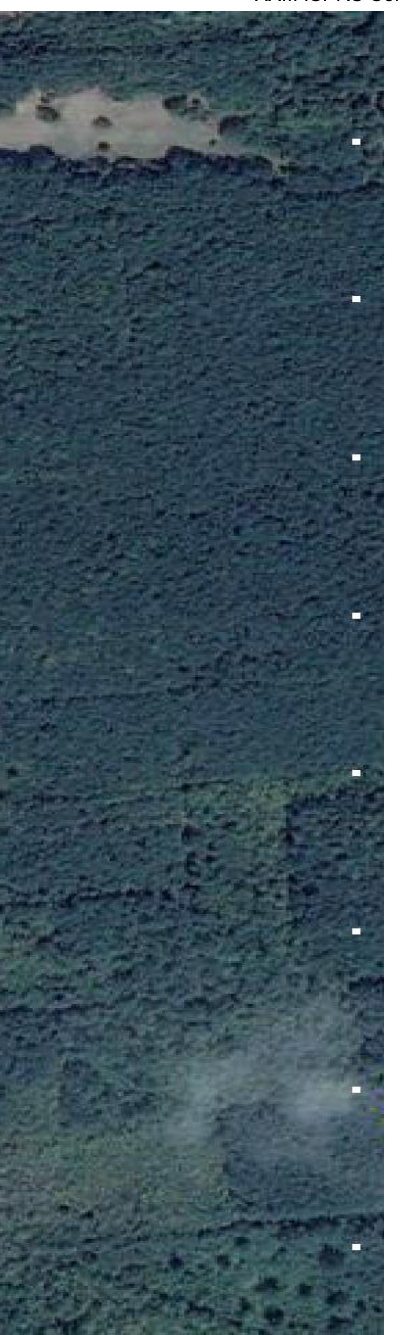
Figure 7. Left panel: satellite image of the forested transect (for reference). Spacing of white dots are 100 m. Right panel: visualizations of L ( r , h ) images calculated for the same area for each 30 m. The colour scale and extents are the same as in Fig. 5, spacing and position of the white dots are the same as in the left